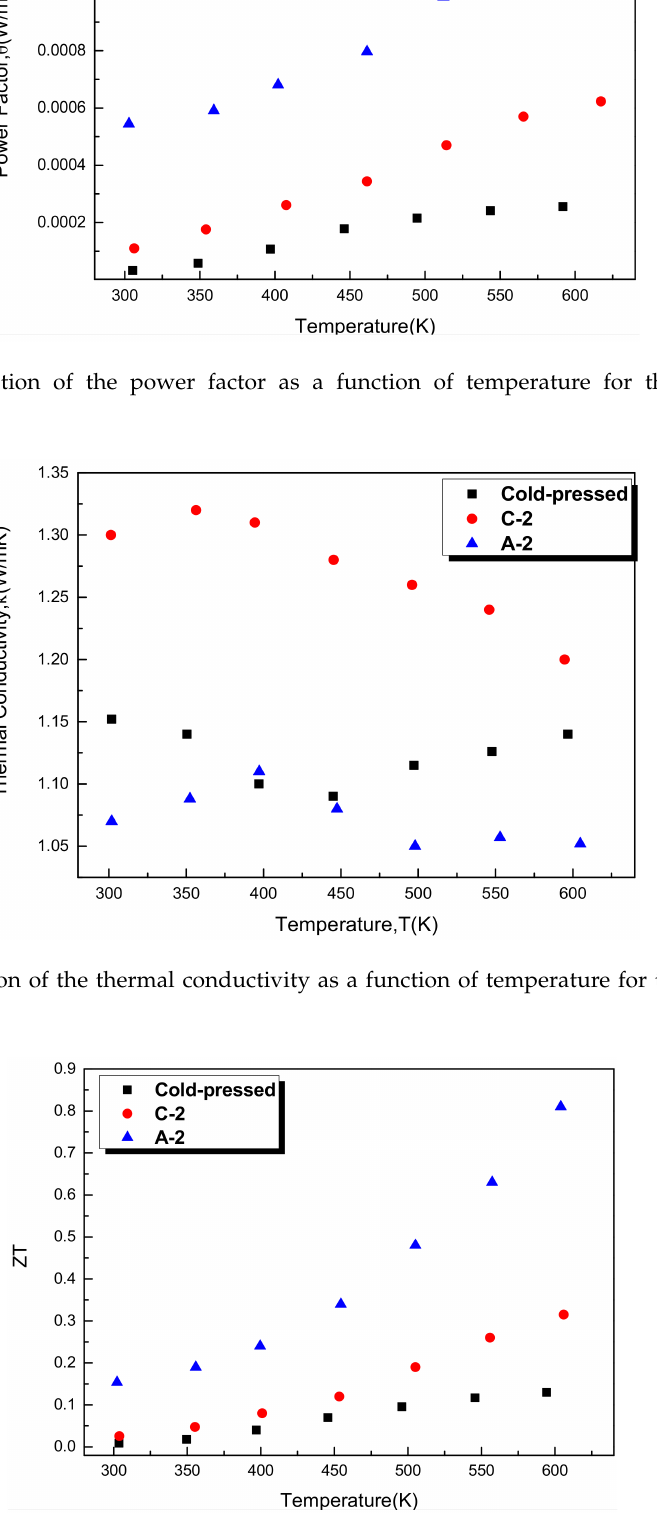
Figure 12. Variation of the ZT values as a function of temperature for the hot pressed Zn 4 Sb 3